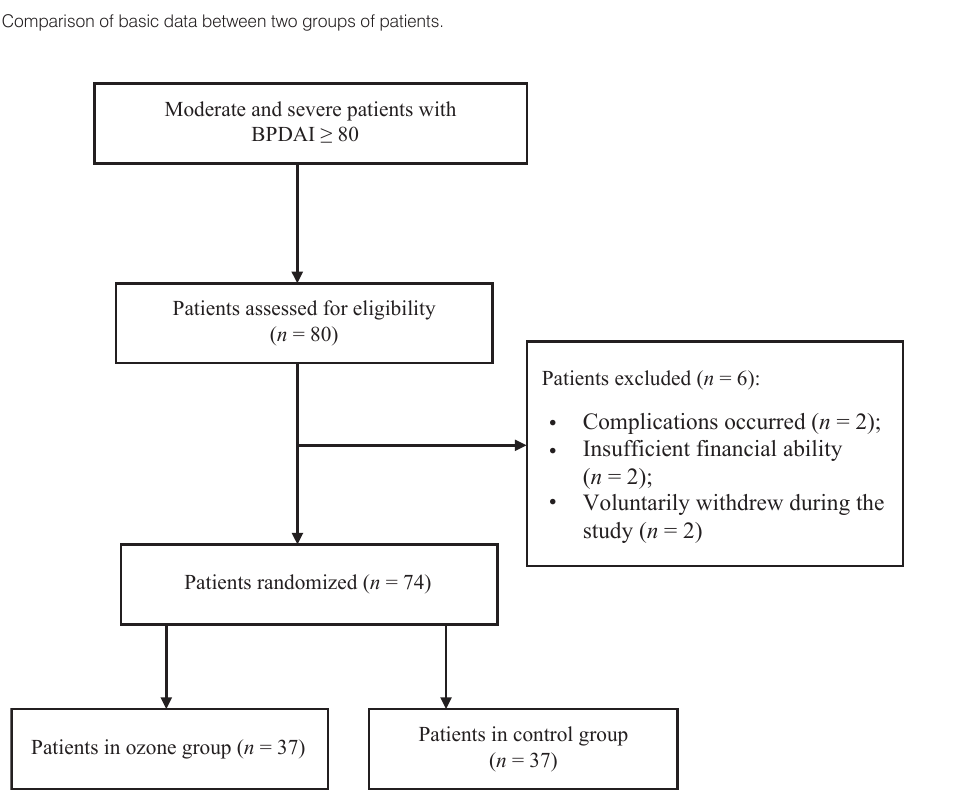
Figure 1. Research object screening flow chart. BPDAI, bullous pemphigoid disease area